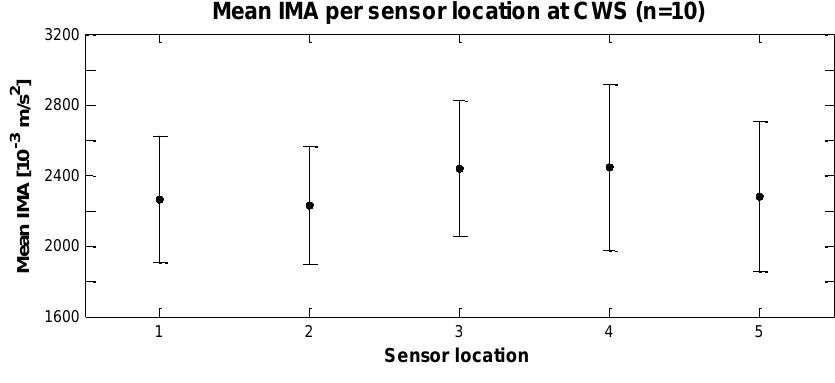
Figure 7. Error bars with 95% confidence Intervals for IMA values from all 5 sensor locations, at comfortable walking speed